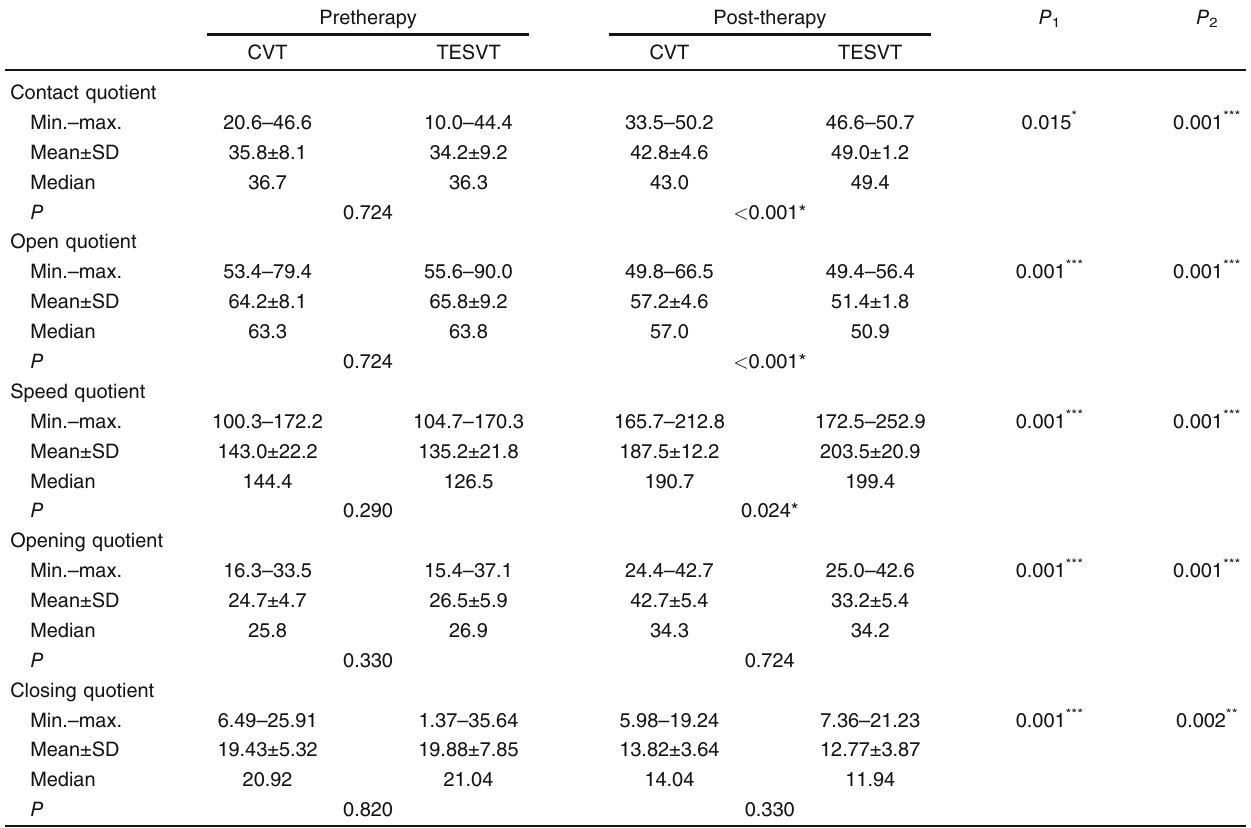
Table 6 Pretherapy and post-therapy electroglottography of both studied groups